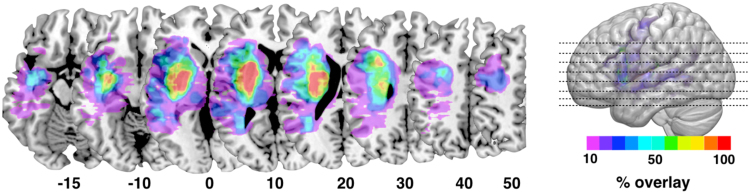
Percentage lesion overlay maps based on lesion masks delineated on T1-weighted images.